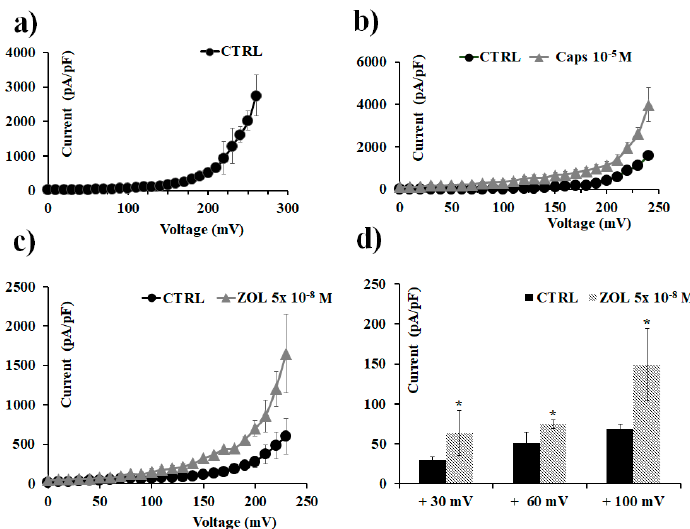
Figure 9. Transient receptor potential vanilloid 1 (TRPV1) channel currents recorded in Xenopus laevis oocytes in inside-out configuration, and capsaicin and ZOL effects. Current was recorded